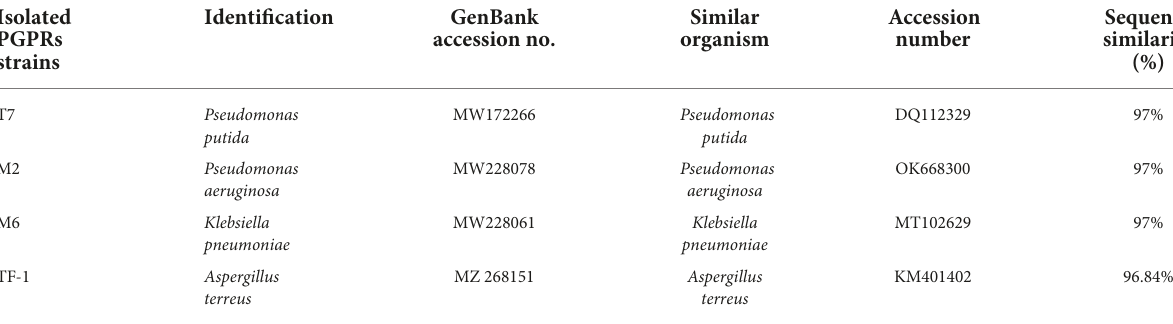
TABLE 1 Homology search of isolated Plant growth promoting rhizobacteria (PGPRs). Isolated